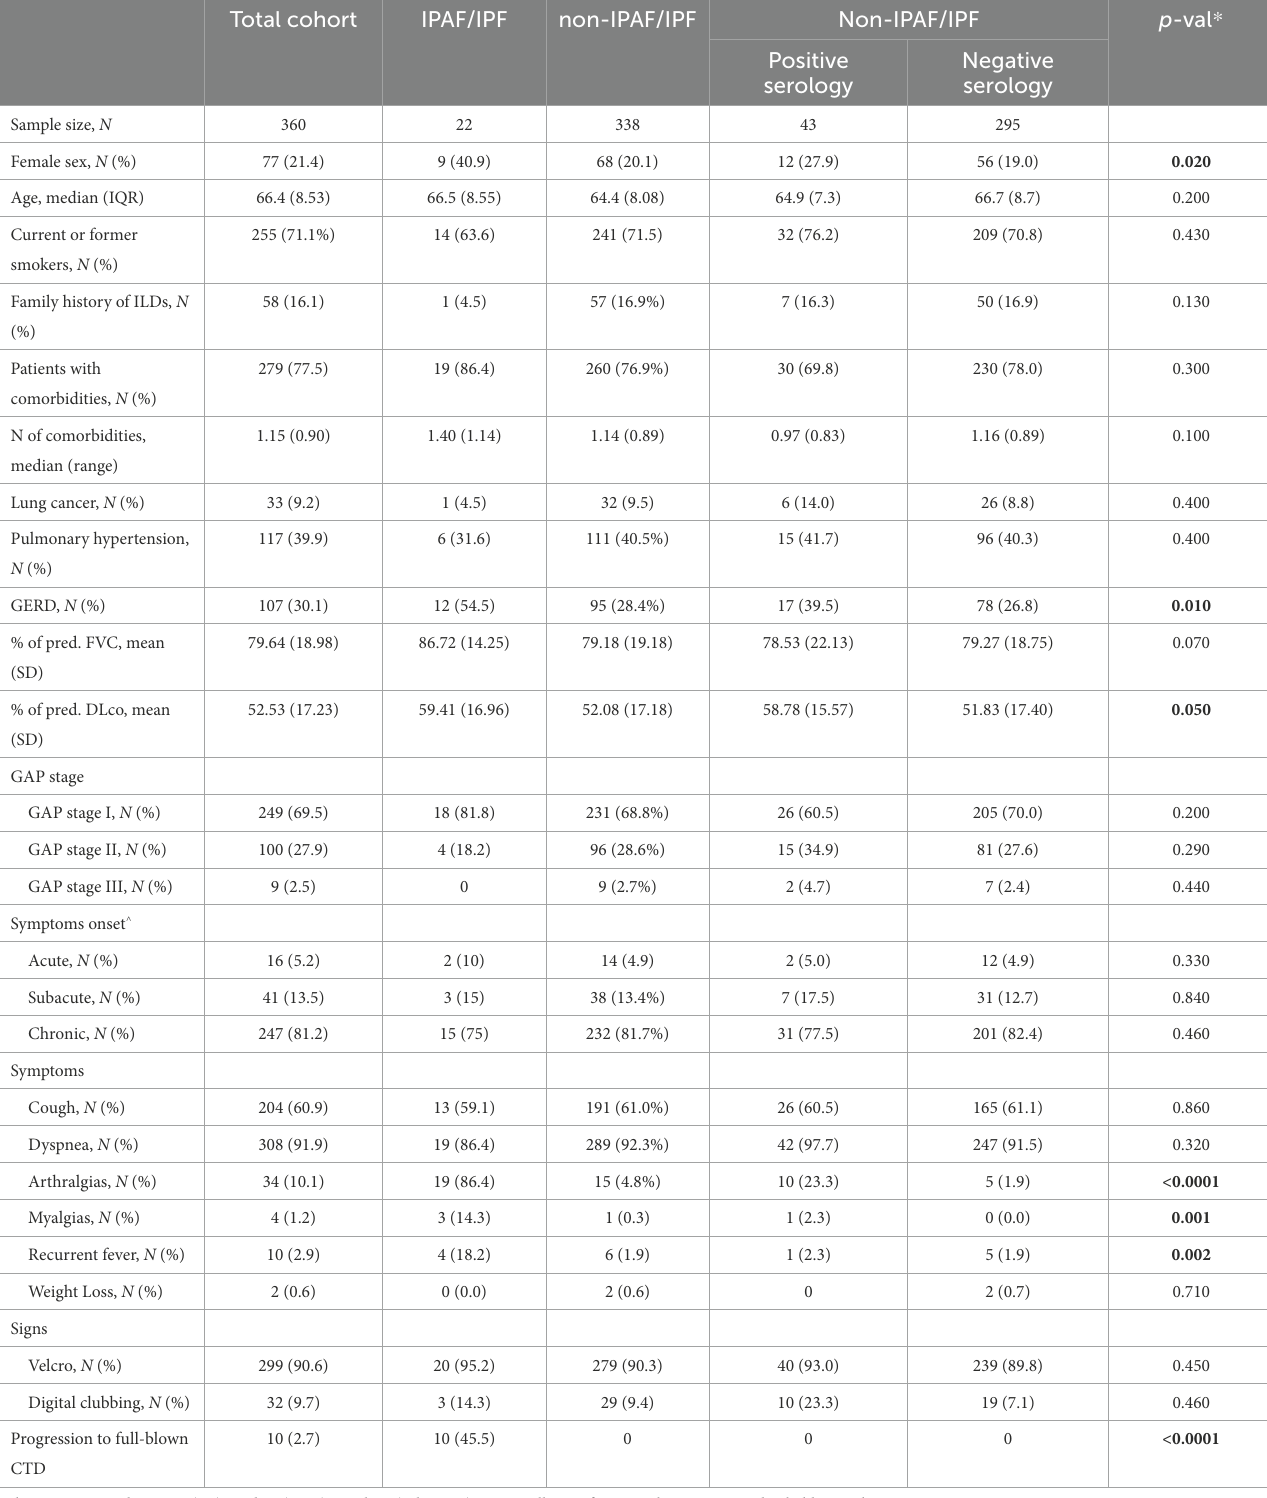
TABLE 1 Patient characteristics and comparison between IPAF/IPF and